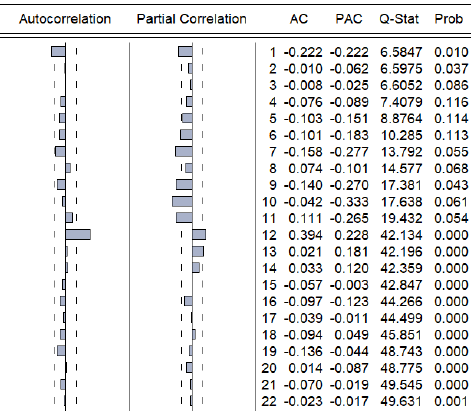
Figure 4. Autocorrelation plots and partial autocorrelation plots .